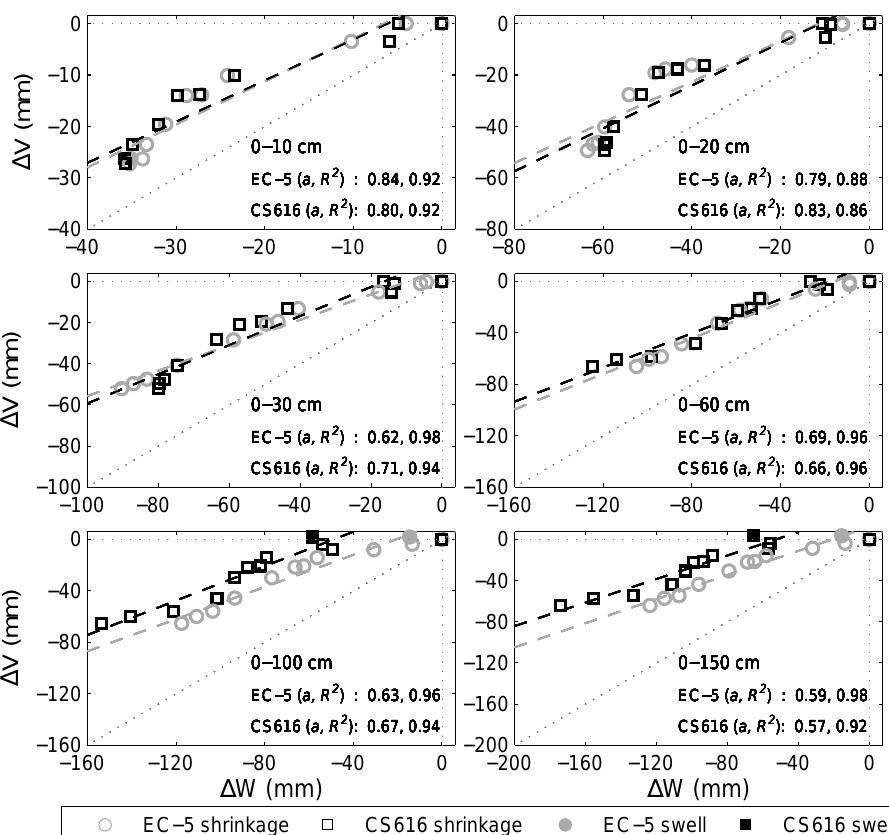
Fig. 5. Relationship between volume change per unit area 1V and water storage change 1W (EC-5 and CS616) at field A in 2011, for six soil layers. Dashed lines represent linear regression fits through data points outside the structural shrinkage phase, with a indicating the slope of the fit and R 2 being the goodness of